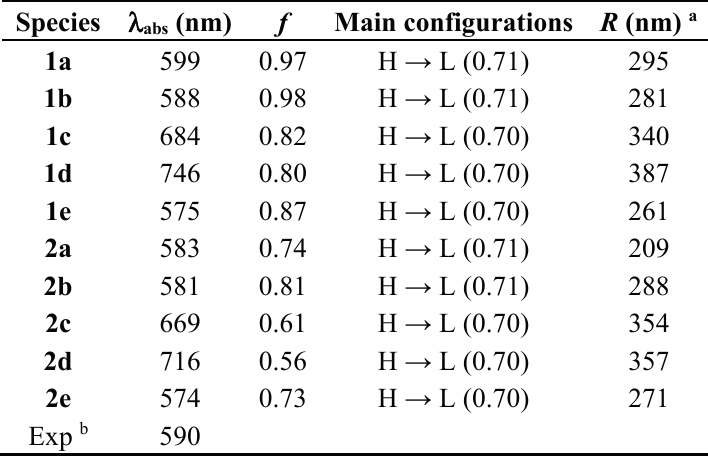
Table 2. Predicted absorption region R , the longest wavelength of absorption, corresponding oscillator strength f , and main configurations of the compounds under investigation at the TD-B3LYP/6-31G(d,p)//B3LYP/6-31G(d,p) level. Species λ (nm) f Main configurations R (nm) abs